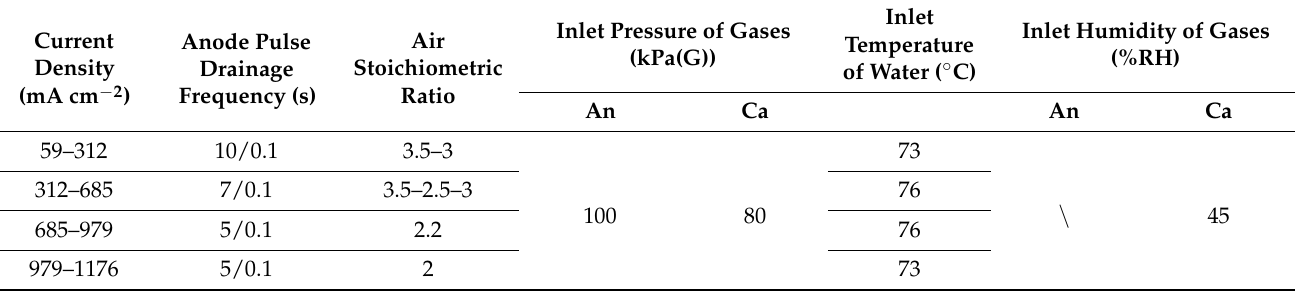
Table 2. Operating conditions in the dynamic load